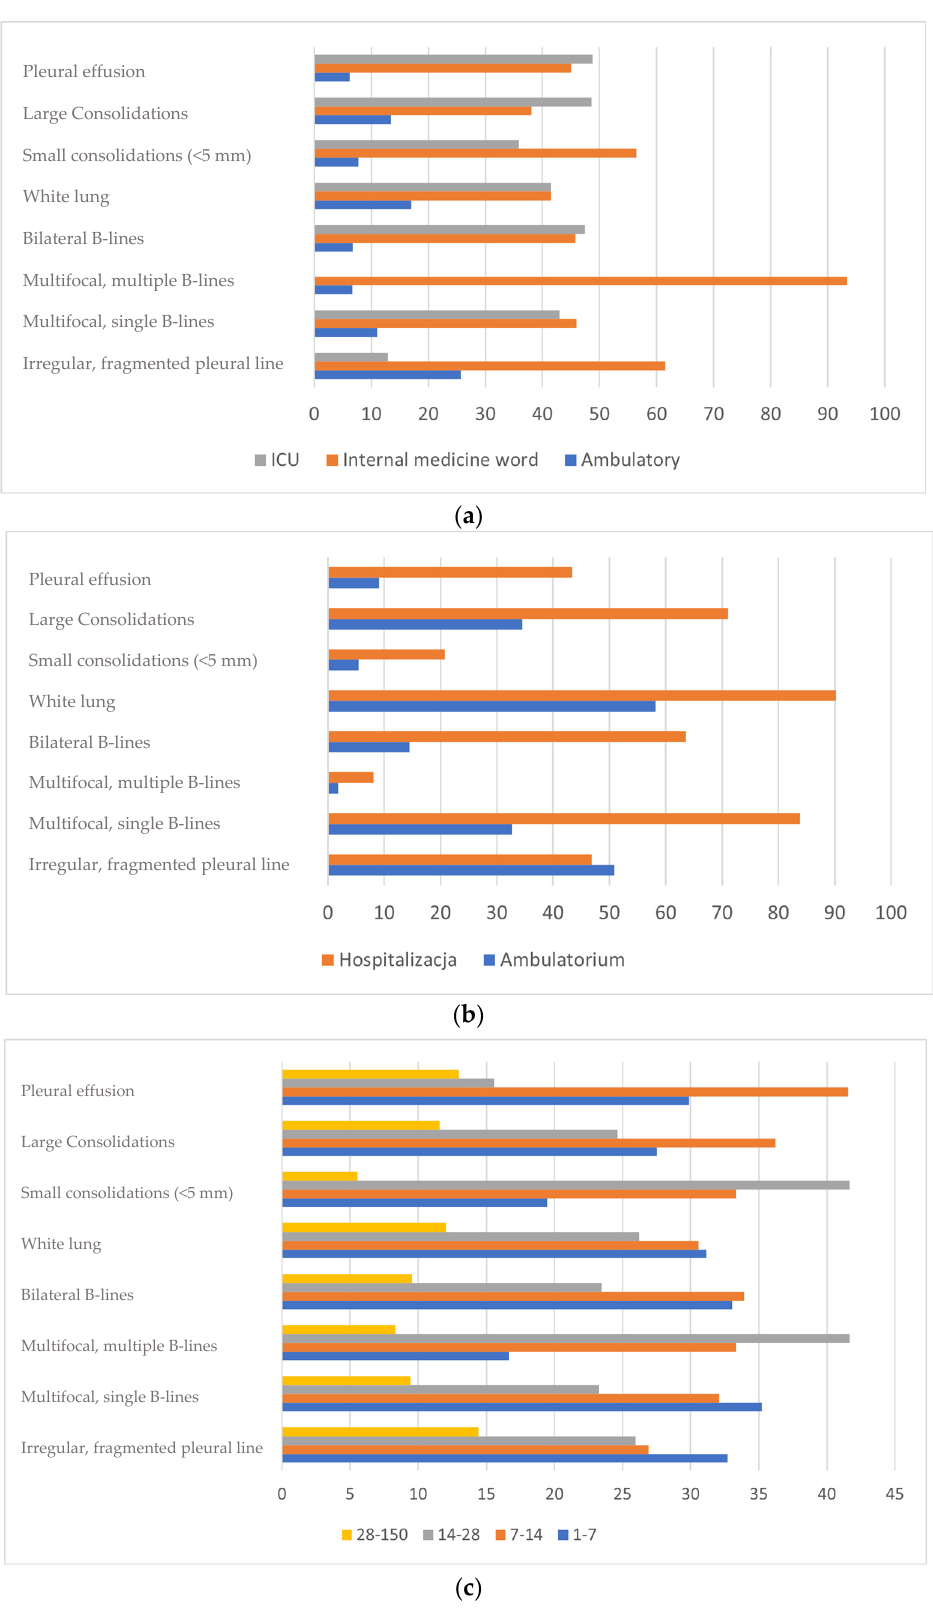
Figure 6. Figures demonstrate the presence of specific LUS findings in patients with the SARS-CoV-2 infection depending on: ( a ) place of treatment (ambulatory, department of internal medicine, intensive care unit), ( b ) treatment mode (ambulatory and hospitalization), ( c ) period of illness.